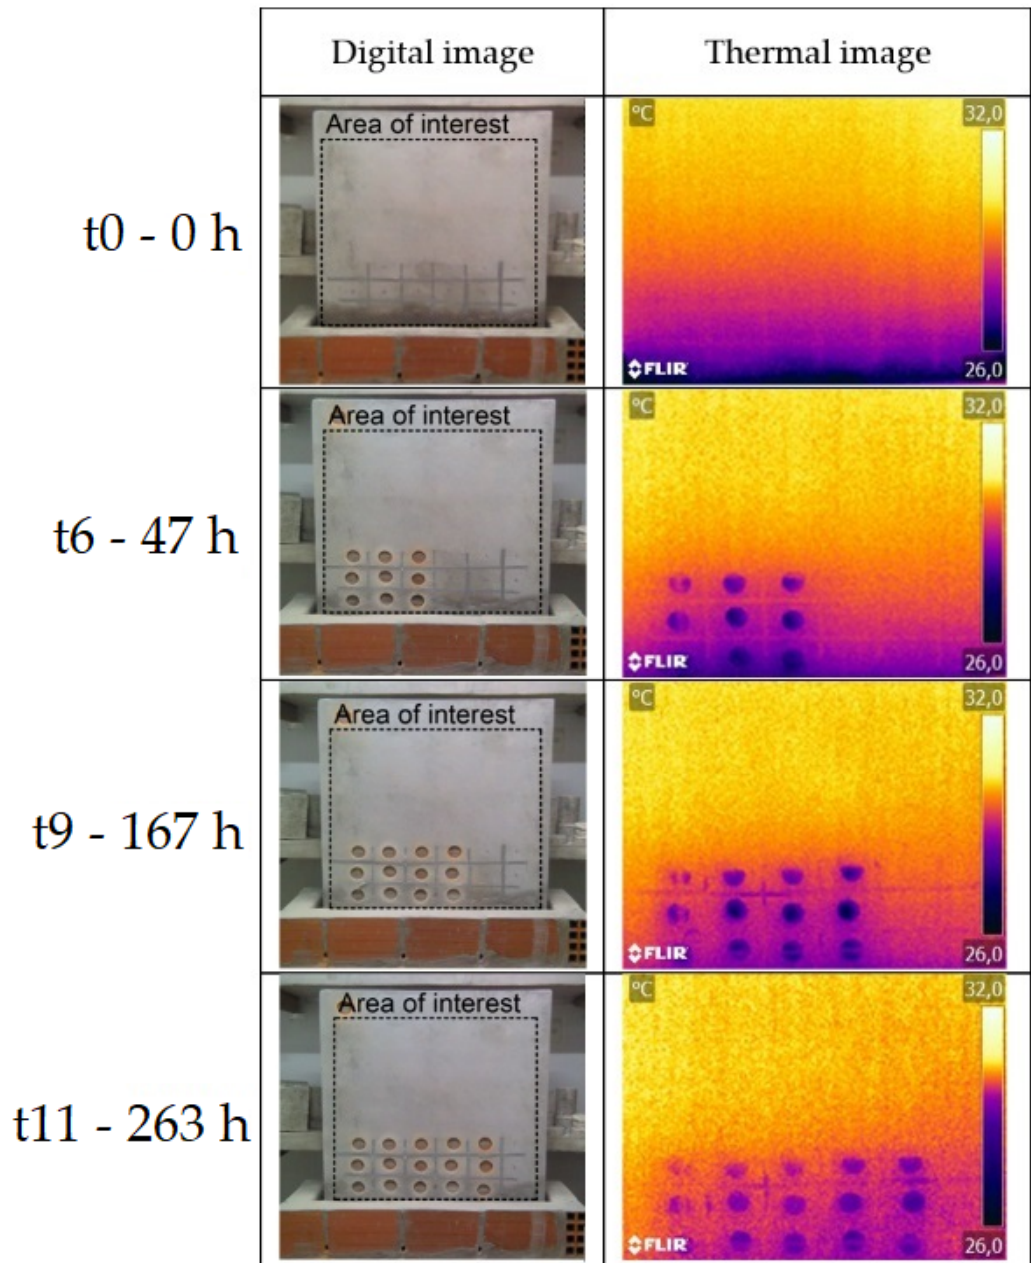
Figure 7. Digital images and thermal images of the drying test of the wall in the hot chamber.